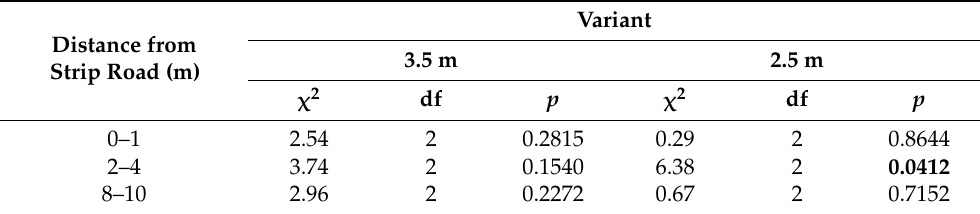
Table 6. Chi-square test results between the eccentricity direction (S-W, N-W) and height on the stem (value in bold denotes statistical significance).